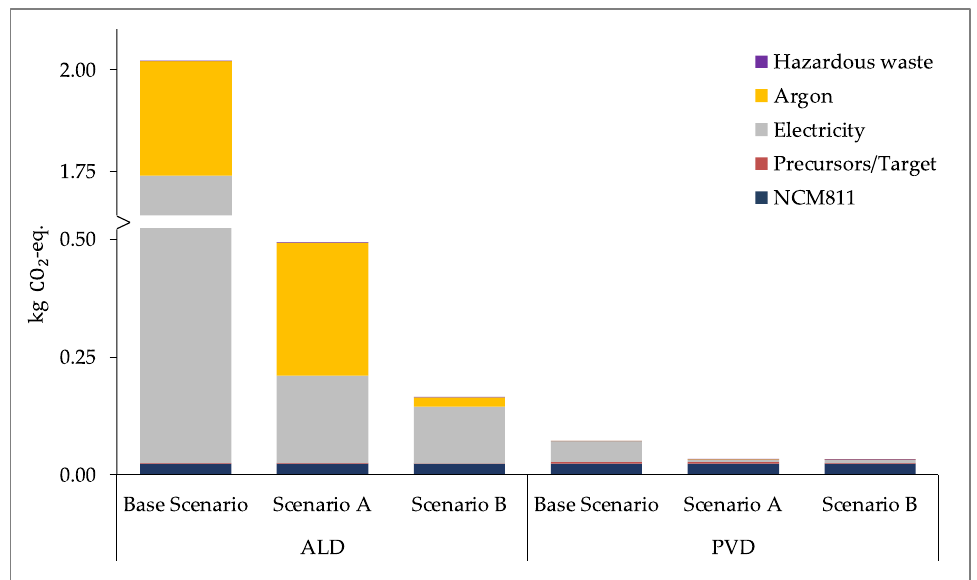
Figure 8. LCIA Results of the Scenario Analysis per 1 g of Input NCM811 for the Climate Change Impact Category.